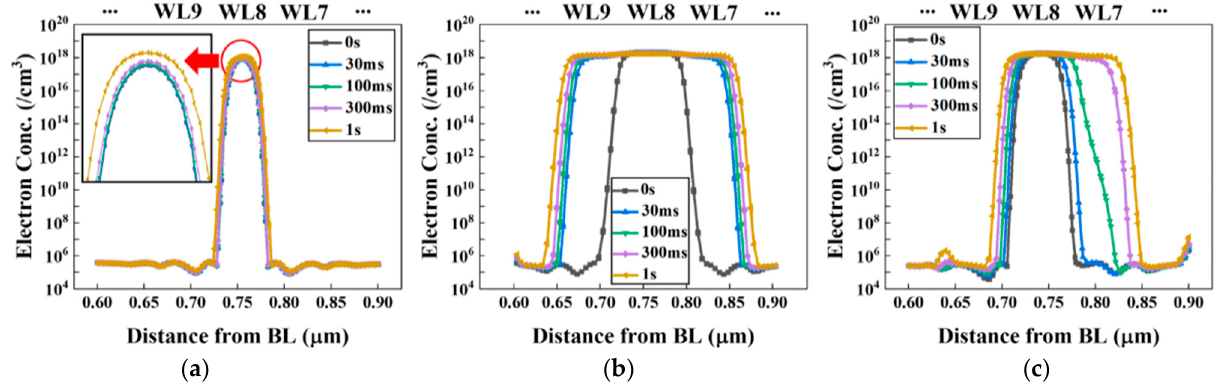
Figure 5. Electron concentration profiles for various transient time of ( a ) P1 and ( b ) P3, whereas ( c ) is graph of electron concentration when WL9 is programmed as P3.